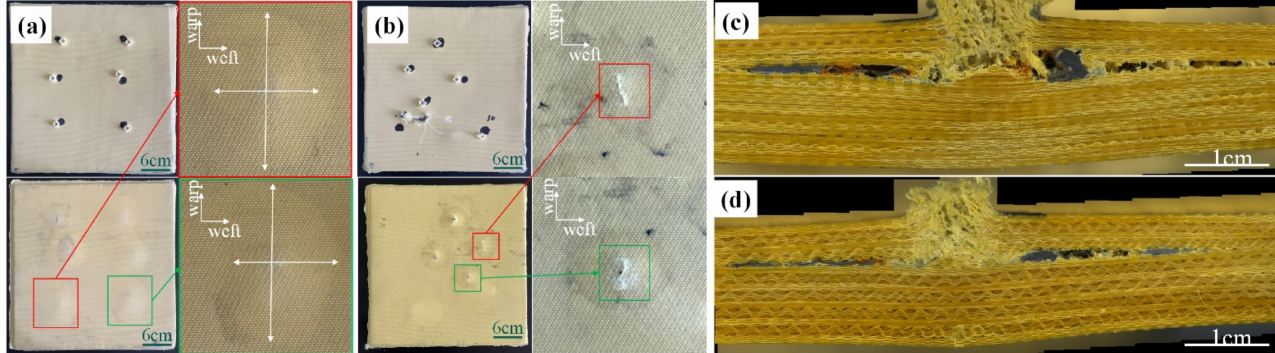
Figure 18. Destruction morphologies of the target plate under different layup methods: ( a ) unilateral ply, ( b ) orthogonal layup; ( c ) cross-sectional view of unilateral ply; and ( d ) cross-sectional view of orthogonal